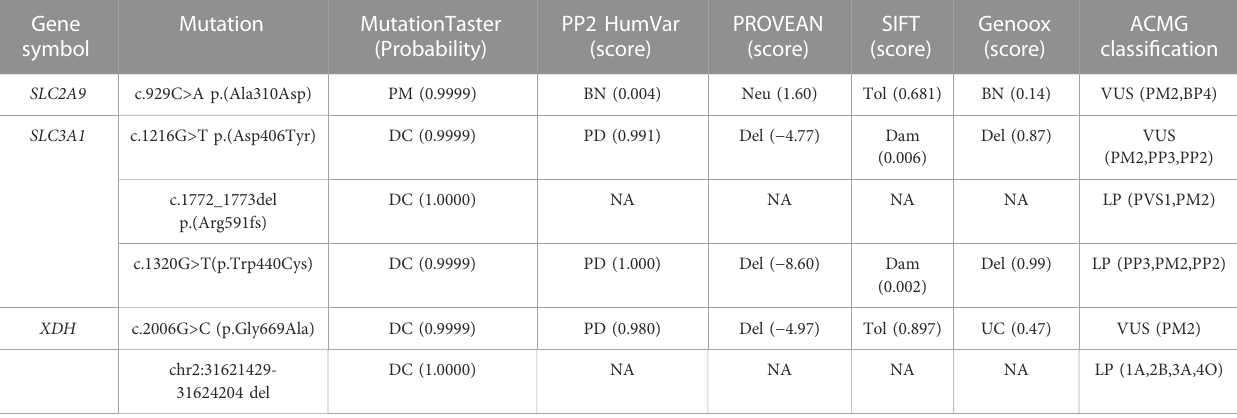
TABLE 5 Pathogenicity of six novel mutations in 30 stone-causing